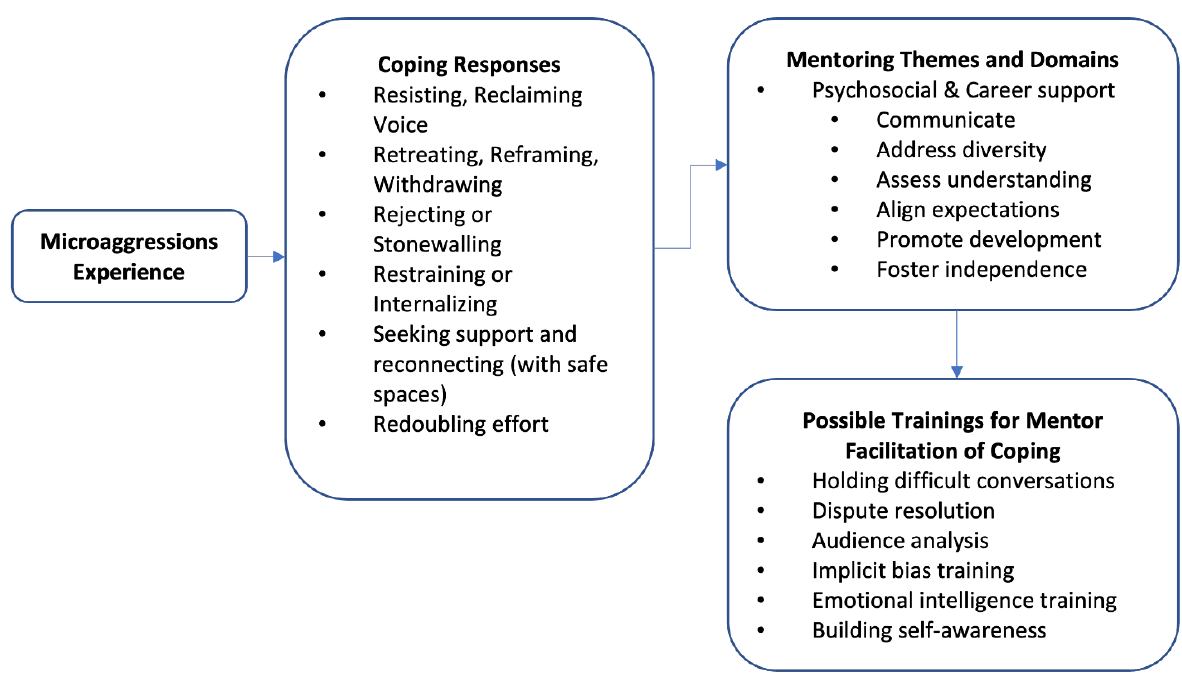
Figure 1. Coping mechanisms and forwarded mentoring linkages.